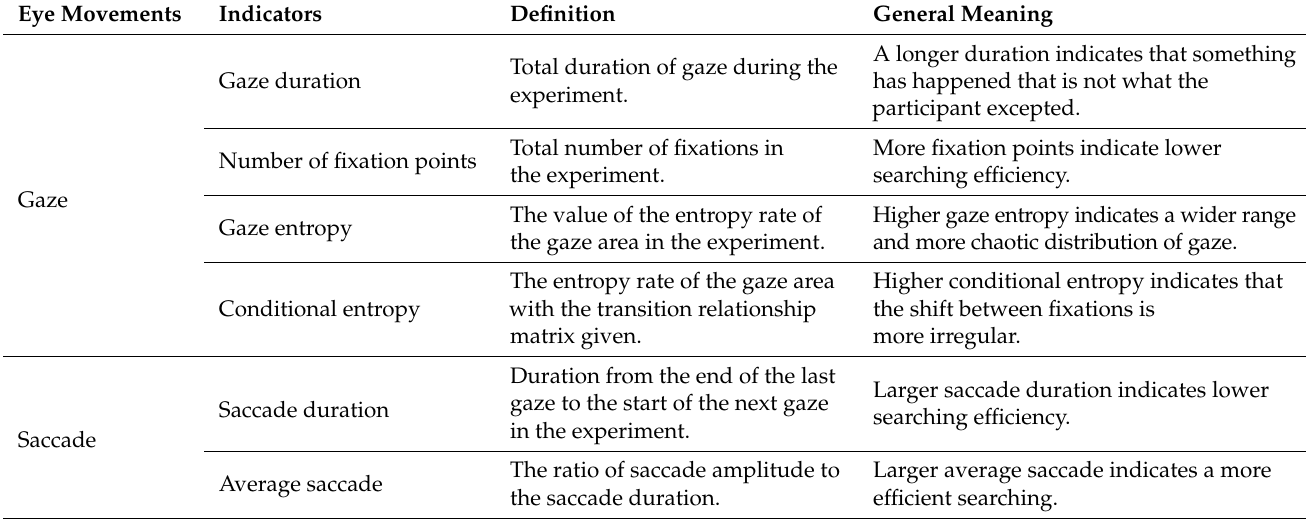
Table 3. Eye movements